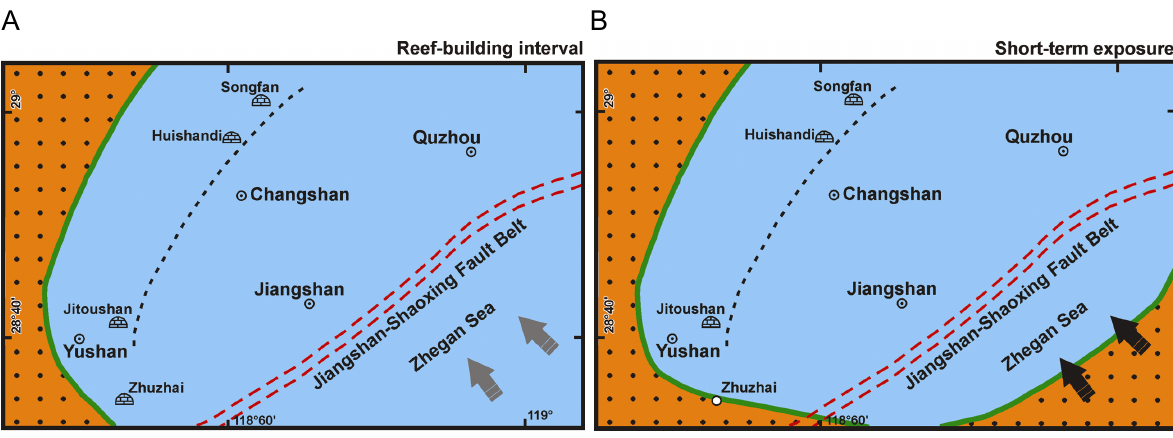
Fig. 5. Palaeogeographic changes during the Late Katian (modified from Rong et al. 2010). A , reef-building interval (the two reefal units); B , short-term exposure. Double red dashed lines indicate the Jiangshan(cid:150)Shaoxing Fault Zone; the yellow-brown area with black dots indicates oldland; green lines show the proposed palaeo-shoreline; semicircular limestone mark shows carbonate mud mounds and reefs; black dashed lines indicate the platform margin; grey arrows show the Cathaysian Block approaching the Yangtze Block; black arrows denote the uplifting and expanding of the Cathaysian